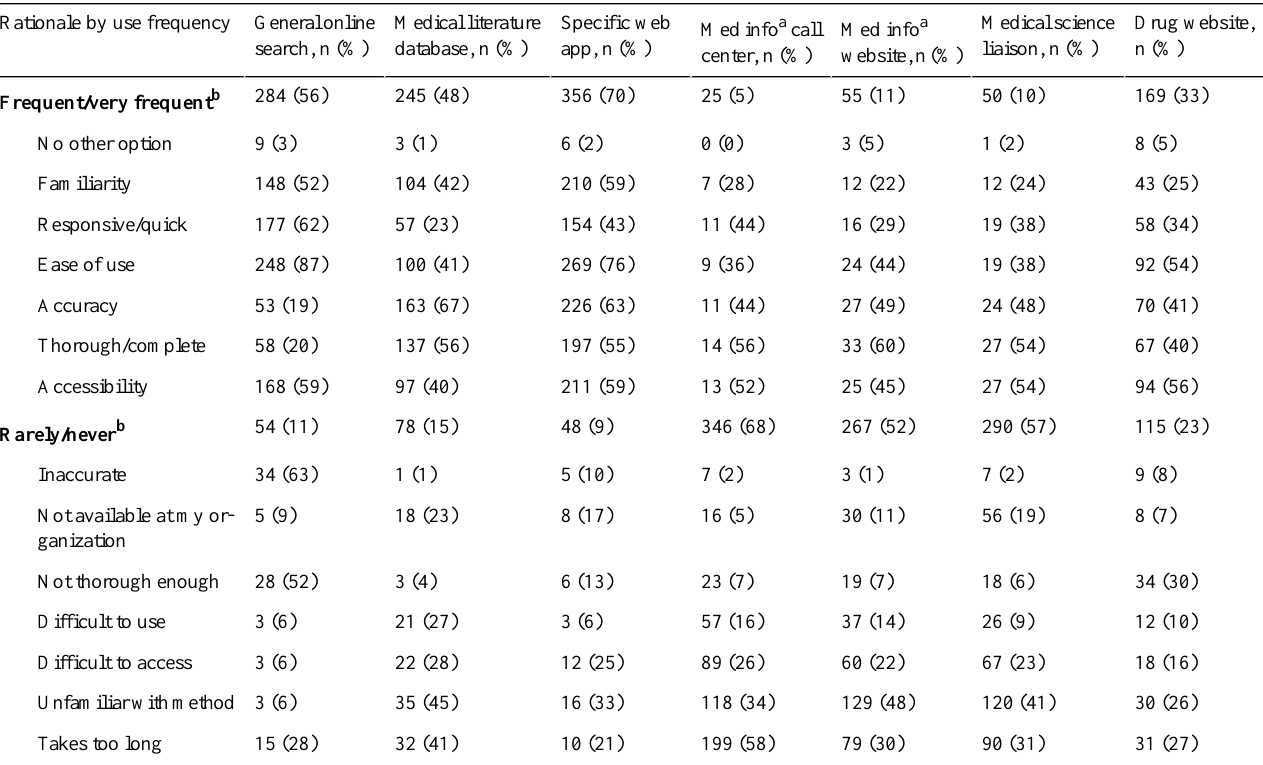
Table 2. Rationale for frequent or very frequent or rarely/never use (N=511).